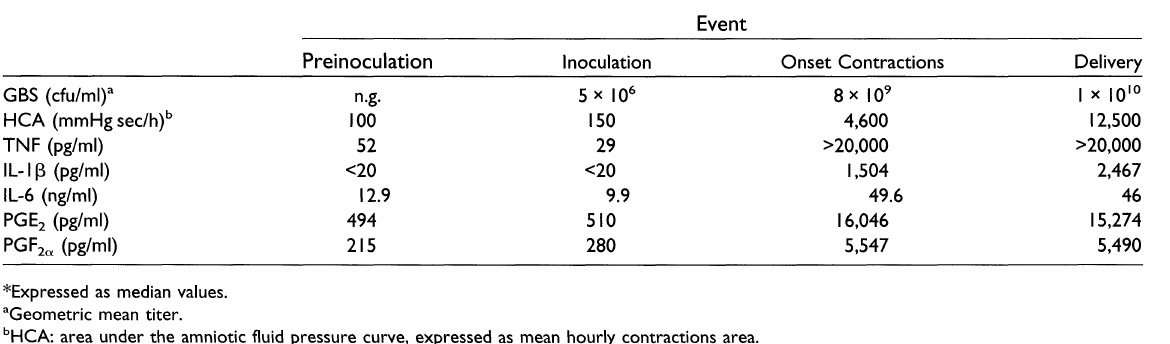
bHCA: area under the amniotic fluid pressure curve, expressed as mean hourly contractions